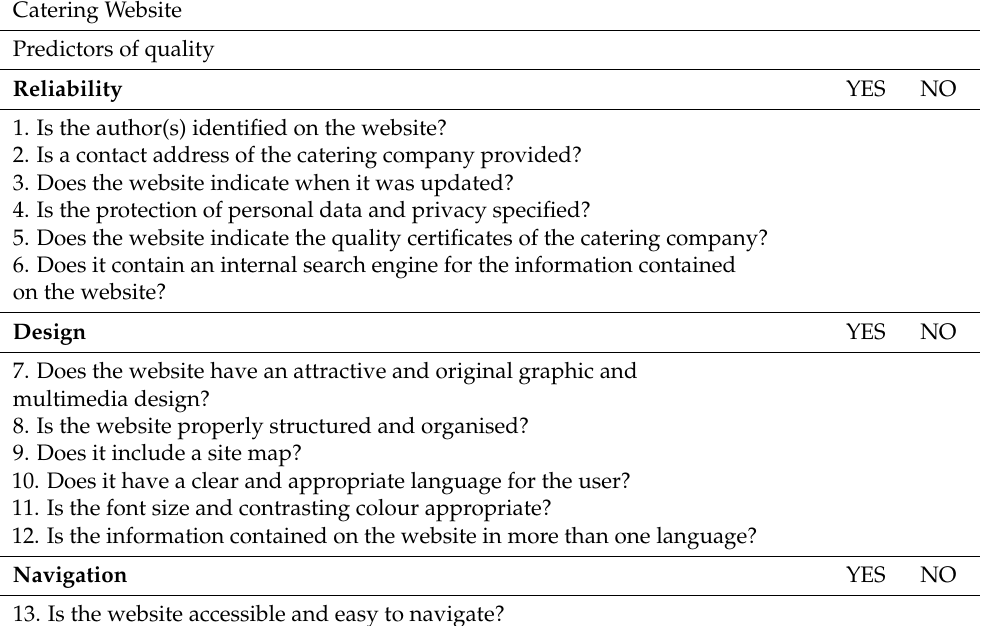
Table 3. Validated EDALCAT questionnaire, for the evaluation of catering websites. Catering